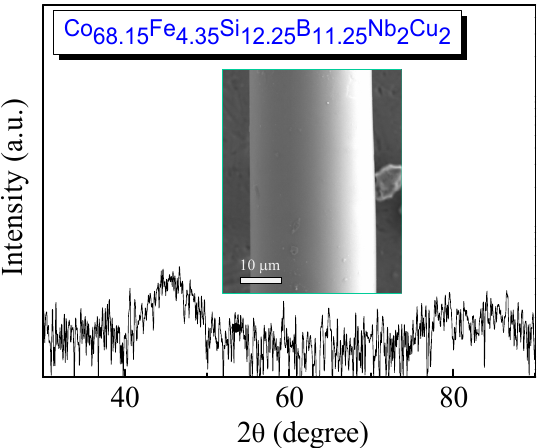
Figure 2. XRD and morphology of the (Co ‐ Fe) ‐ based melt ‐ extracted amorphous microwire.